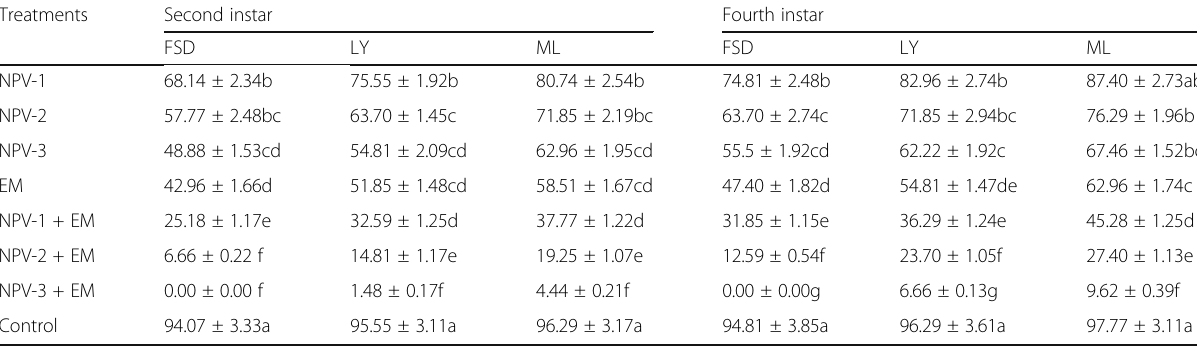
Mean sharing the same letters within each column are not significantly different at 1.0% level